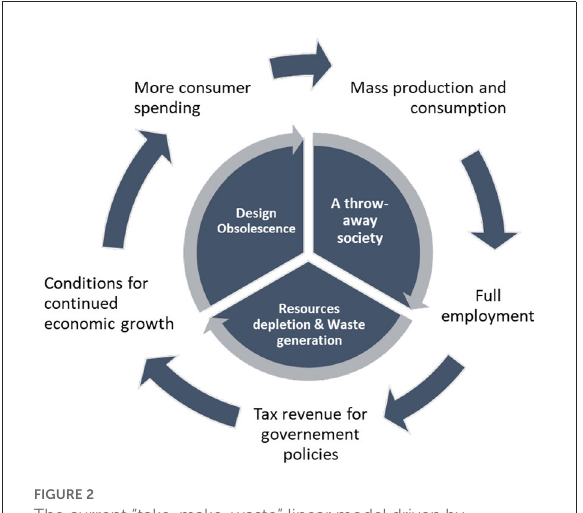
FIGURE2 The current “take-make-waste” linear model driven by consumer